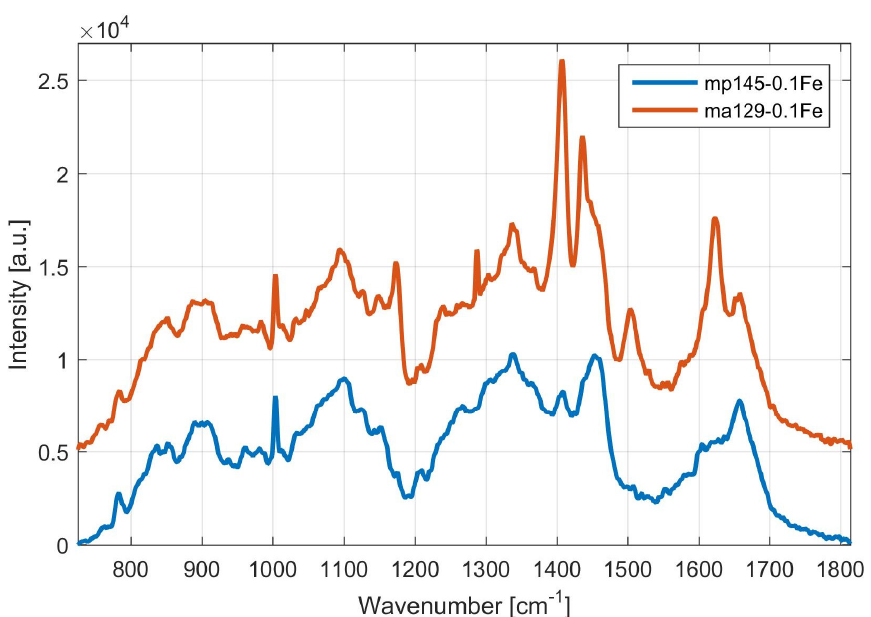
Figure 3. Raman spectra of pulcherrimin produced in media containing 0.1 g/L Fe by yeast Metschnikowia pulcherrima MP145 and Metschnikowia andauensis MA129. Legend: Metschnikowia andauensis 129 cultivated on medium with 0.1 g/L Fe (ma129-0.1Fe, red trace) and Metschnikowia pulcherrima 145 cultivated on medium with 0.1 g/L Fe (mp145—0.1Fe, blue trace). Spectra are vertically shifted for clarity.